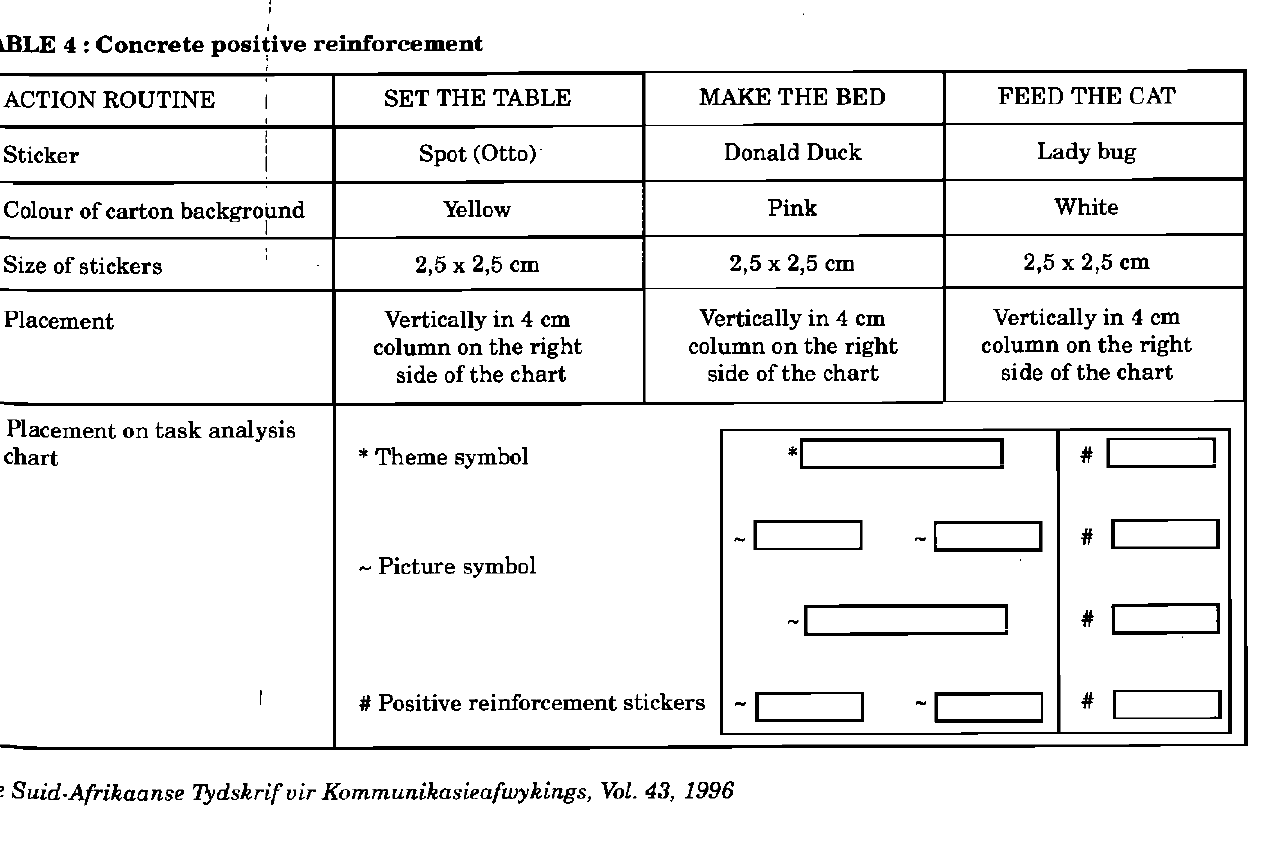
TABLE 4 : Concrete positive